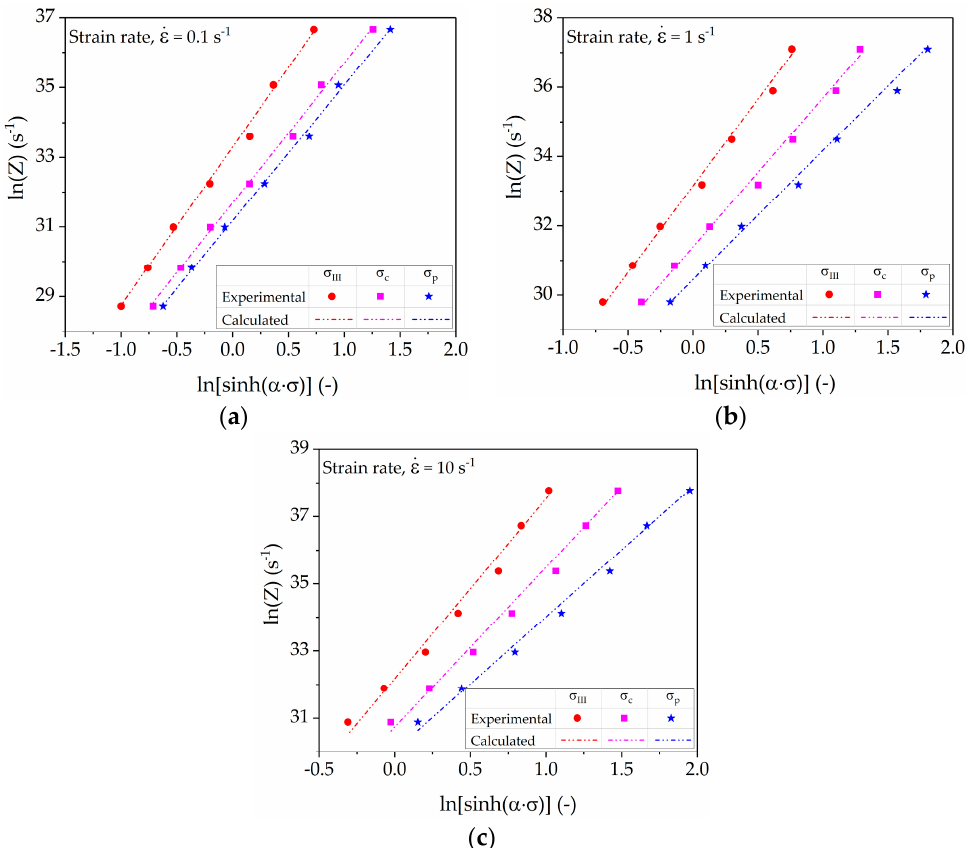
Figure 6. Characteristics points ( σ III , σ c , or σ p ) dependency on Zener-Hollomon-parameter at strain rates of ( a ) 0.1 s − 1 ; ( b ) 1 s − 1 ; and ( c ) 10 s − 1 .